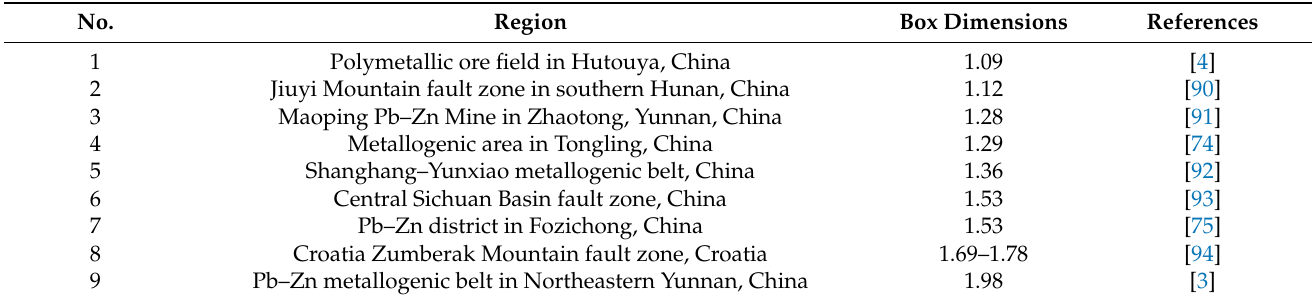
Table 4. Box dimensions of different